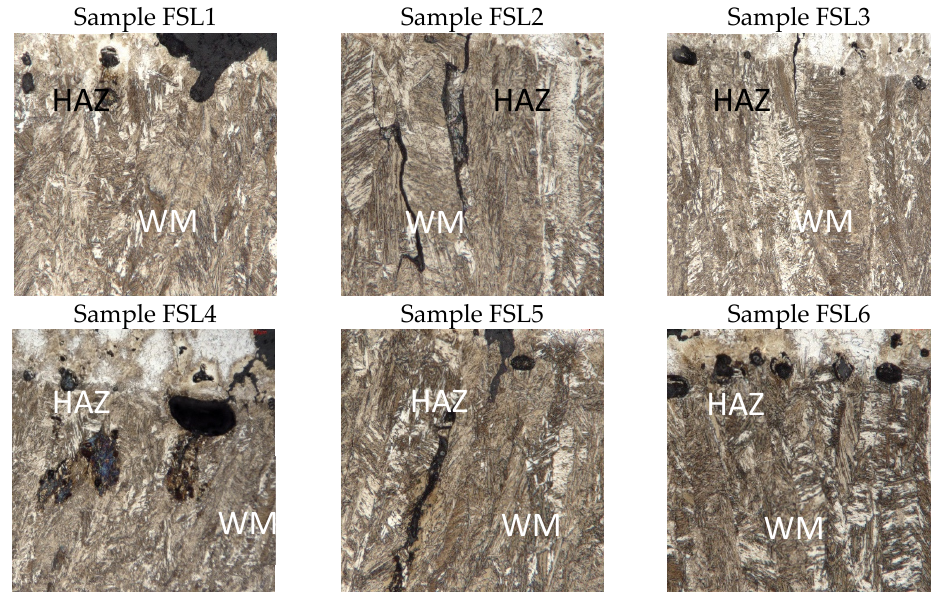
Figure 11. Microscopy images of the welded seams.